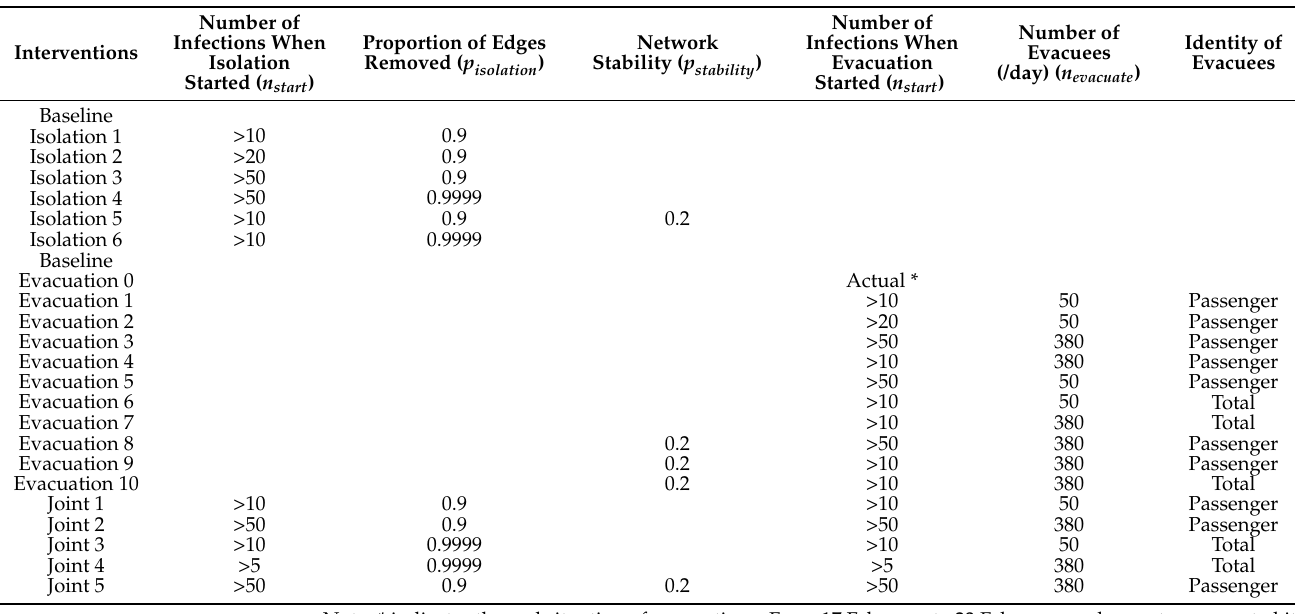
Table 1. Setting of 22 intervention